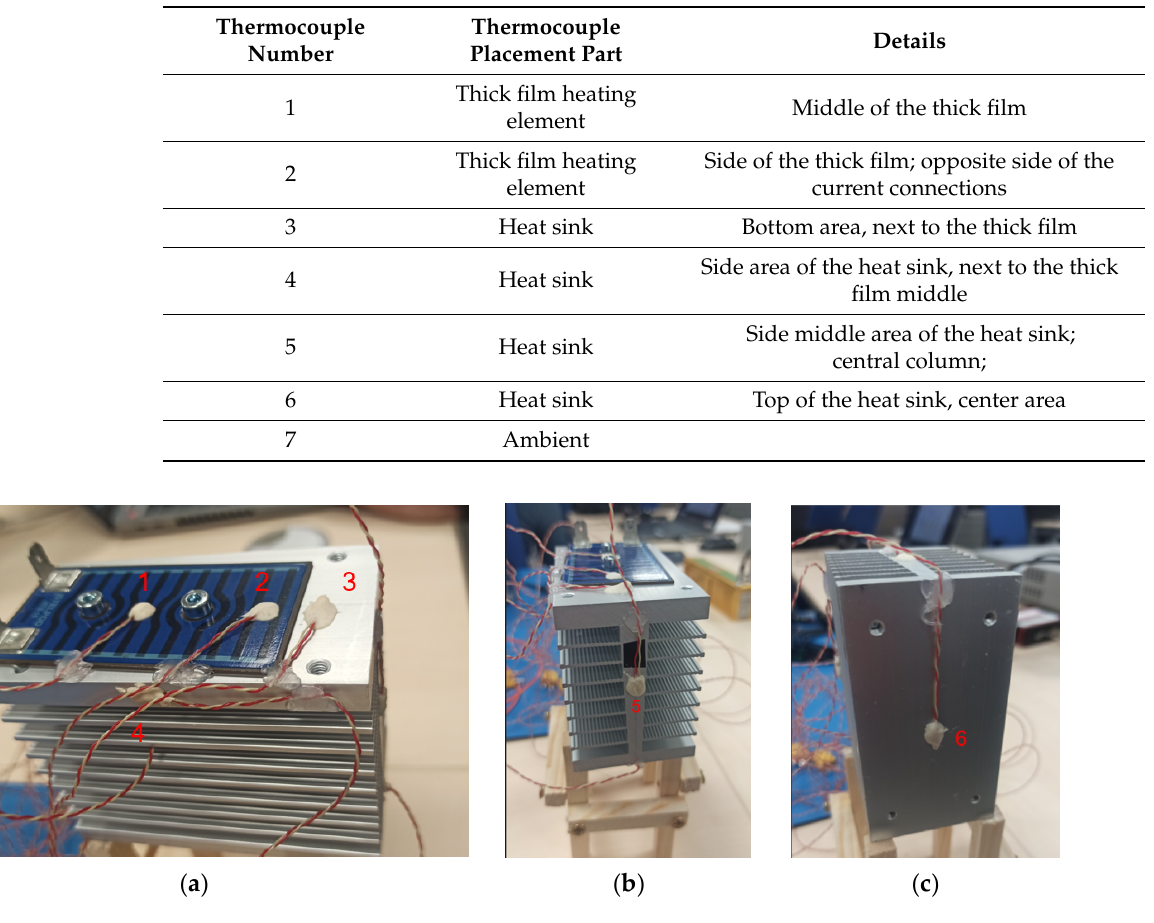
Figure 3. ( a ) Top view of the assembly and position of thermocouples 1 to 4; ( b ) Side view of the measured assembly and position of thermocouple 5; ( c ) Bottom view of the simulation assembly and position of thermocouple